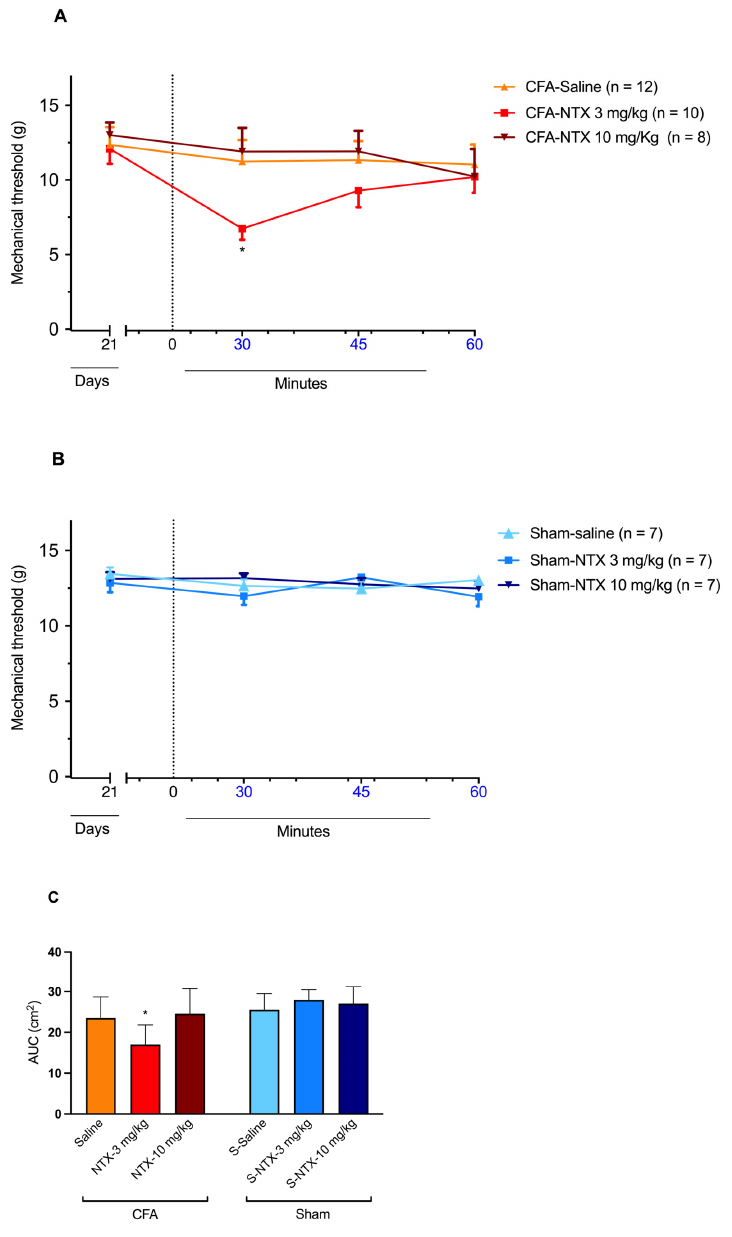
Figure 2. NTX-evoked reinstatement of mechanical allodynia in CFA-21d male Wistar rats. ( A ) The graph shows the time course of mechanical allodynia after subcutaneous administration of 3 mg/kg